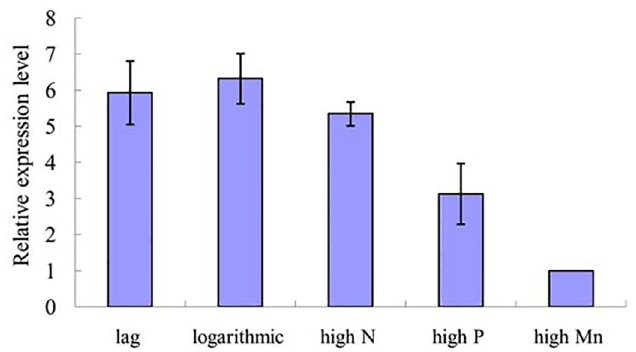
Fig 8. qPCR validation of the differentially expressedaca-miR-3p-456915. Normalized expression level (2 – ΔΔ CT ) of tae-miR159a and aca-miR-3p-456915 under different growth phases and